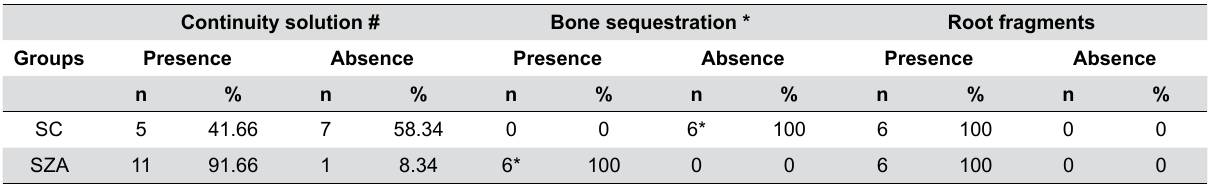
ANOVA test: p=0.323 Table 2- Presence/absence frequency of oral mucosal solution of continuity, bone sequestration and root fragments and in the socket area after maxillary molar extractions, in the SC and SZA groups